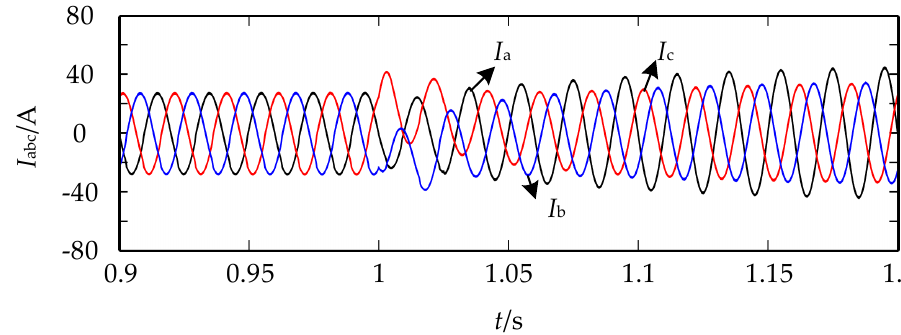
Figure 16. Three-phase current with no DC voltage ripples. Figure 16. Three ‐ phase current with no DC voltage ripples.